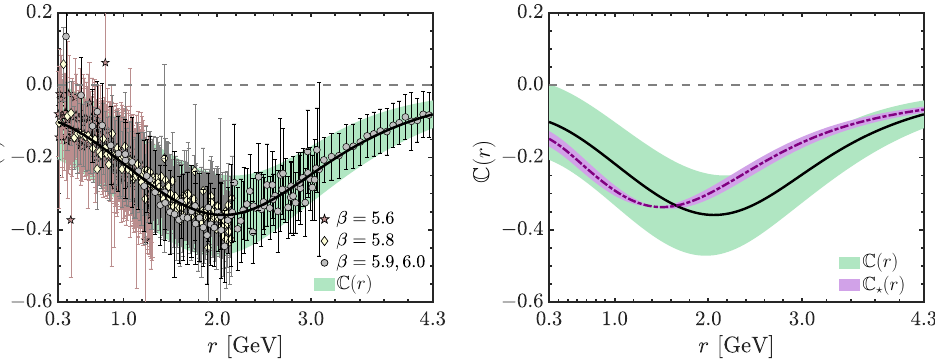
Figure 22. Left : Result for C ( r ) (black continuous line) obtained from Equation (109) using the ( r ) shown in Figure 21, the fits to lattice data for ∆ ( r ) and L sg ( r ) are shown in Figures 9 and 18, W respectively, and the SDE solution for F ( r ) shown in Figure 13. The points are obtained using for L sg ( r ) the data in Reference [84], with error bars denoting the error propagated from L sg and green band is obtained by fitting the upper and lower bounds of the points and guiding the eye to the typical error associated with C ( r ) . Right : The C ( r ) of the left panel is compared to the BSE prediction C (cid:63) ( r ) (purple dot-dashed and error band) of Figure